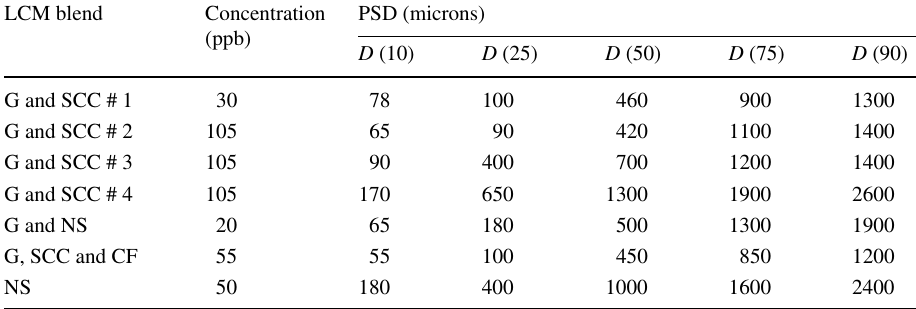
distribution obtained from blending the formulations